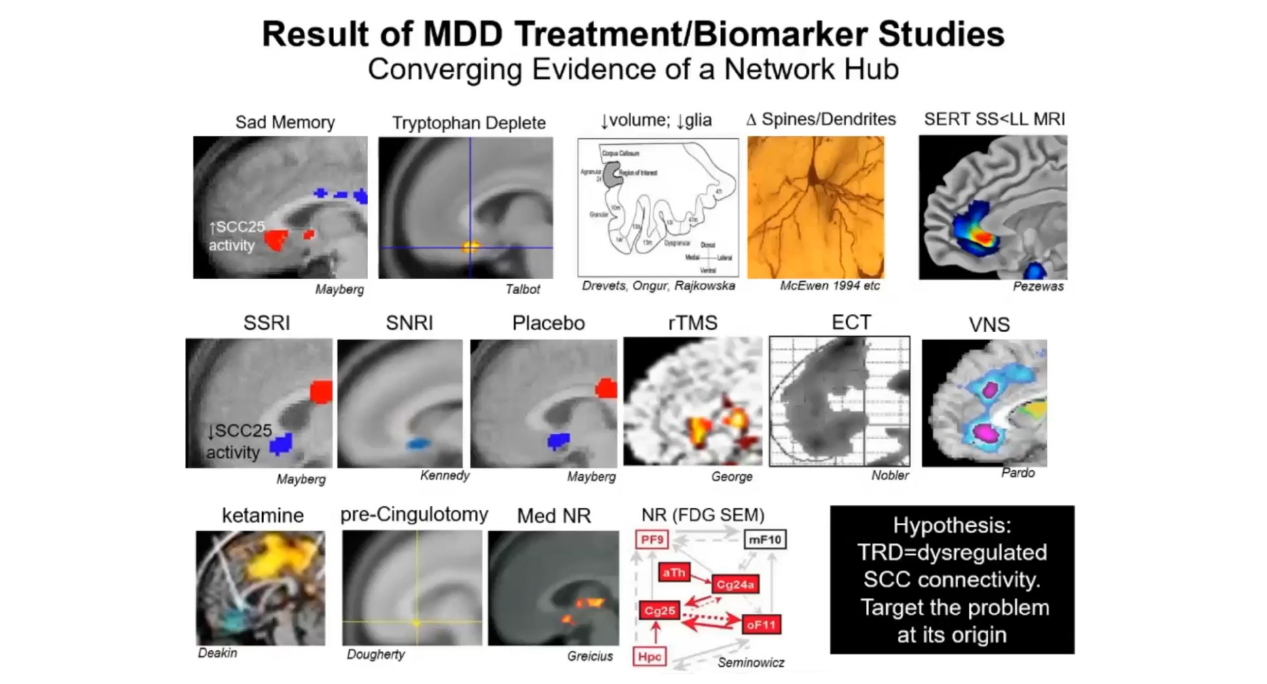
FIGURE1 Understanding where sadness is–This figure illustrates various neuroanatomical localizations of key nodes related to depression as a psychological state, the pharmacological treatment of depression, neuromodulation of depression, and recovery from depression. Through a series of small experiments, this collective information has built a network that identified connectivity to the SCC as a critical player in treatment resistant depression. MDD, major depressive disorder; TRD, treatment resistant depression; SCC, subcallosal